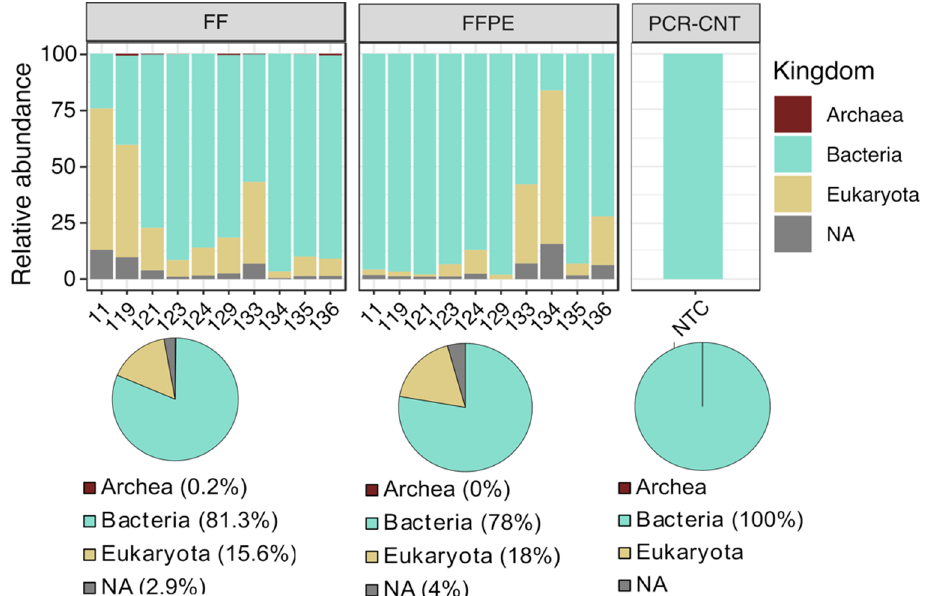
Figure 1. Taxa composition at the kingdom level. Bar plots showing global composition at the kingdom level. Individual samples are reported in the x -axis and relative abundance (as percentage) of taxa in the y -axis. Pie graphs below each panel display the relative abundance of identified taxa in the corresponding group. NA (not available) indicates unassigned ASVs at the kingdom taxonomy rank. Abbreviations: FF; fresh frozen, FFPE; formalin-fixed paraffin-embedded PCR-CNT; PCR no-template control and NTC; no-template control.